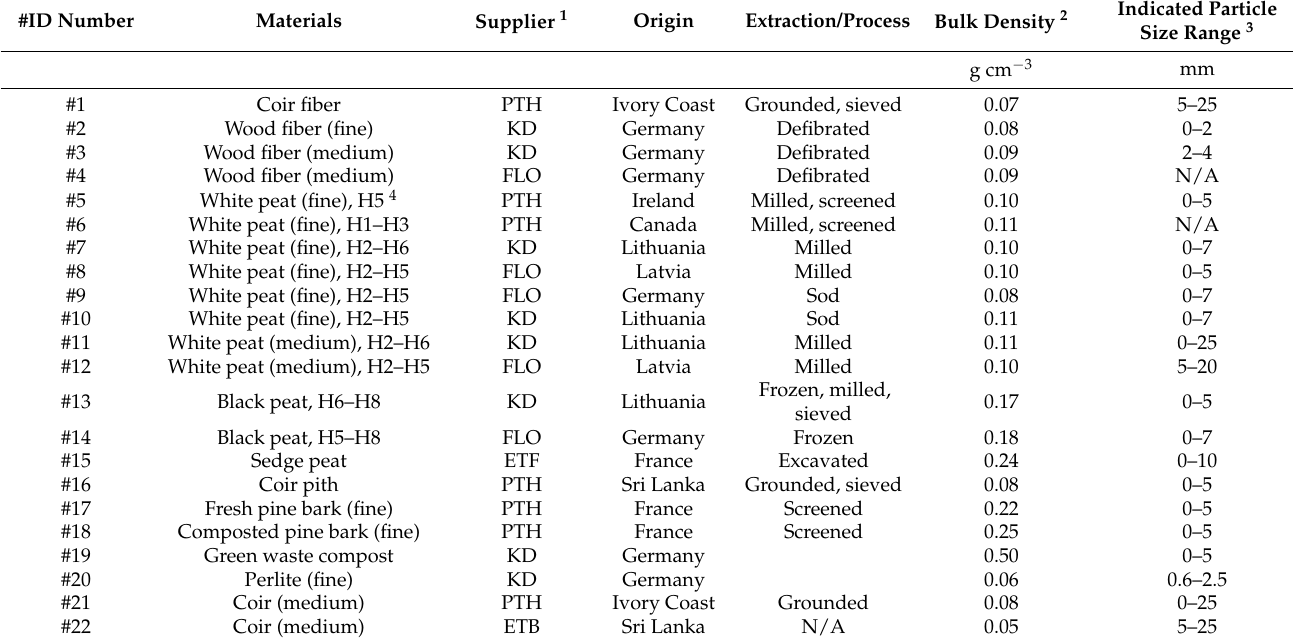
Table 1. Growing media components